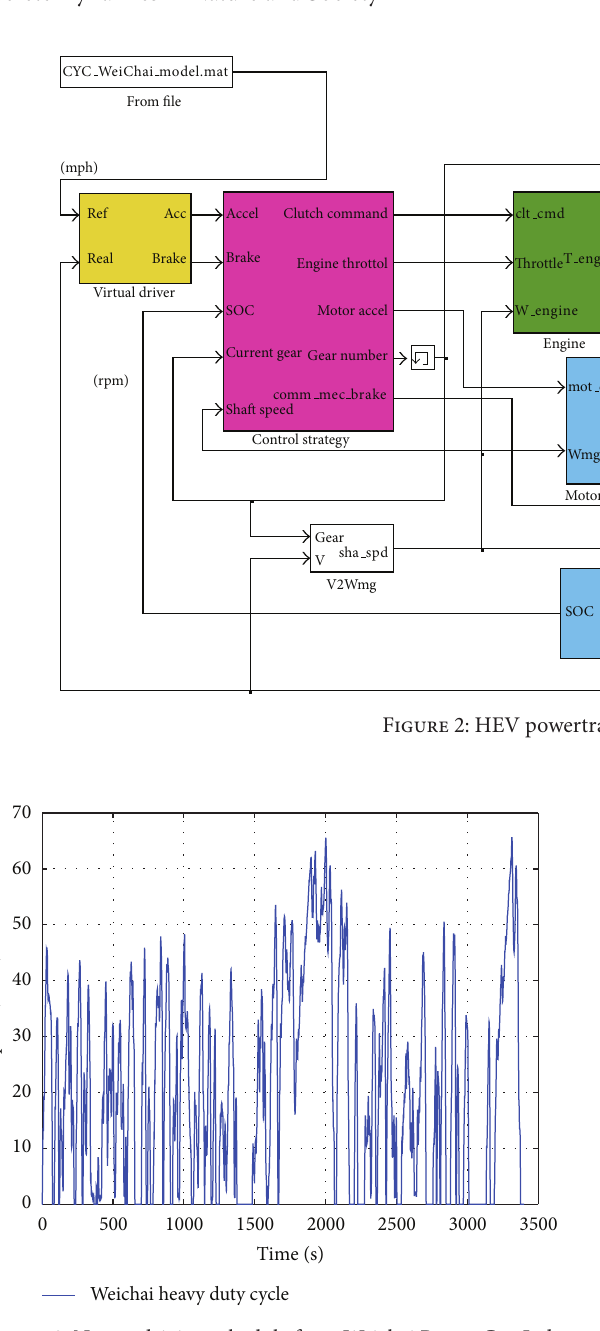
Figure 3: Nature driving schedule from Weichai Power Co., Ltd.